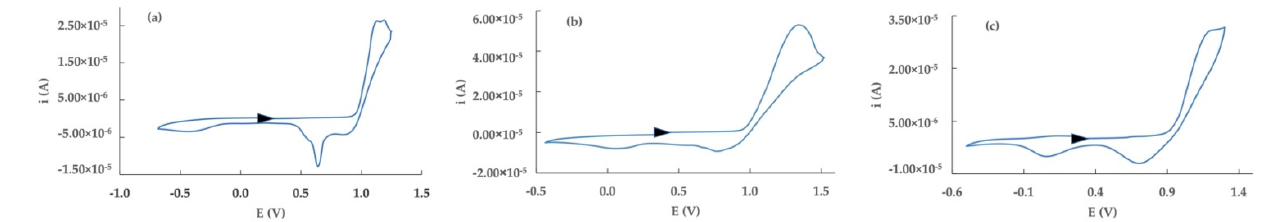
Figure 2. Cyclic voltammetry responses of 2,2 ′ :5 ′ ,2 ″− terthiophene ( a ), 5 − Br − 2,2 ′ :5 ′ ,2 ″− terthiophene ( b ), and 5 − ethynyl − 2,2 ′ :5 ′ ,2 ″− terthiophene ( c ) in CH 2 Cl 2 /0.1 M TEAPF 6 , potential scan rate: 100 mV/s. The black arrow indicates the starting potential and the scan direction.